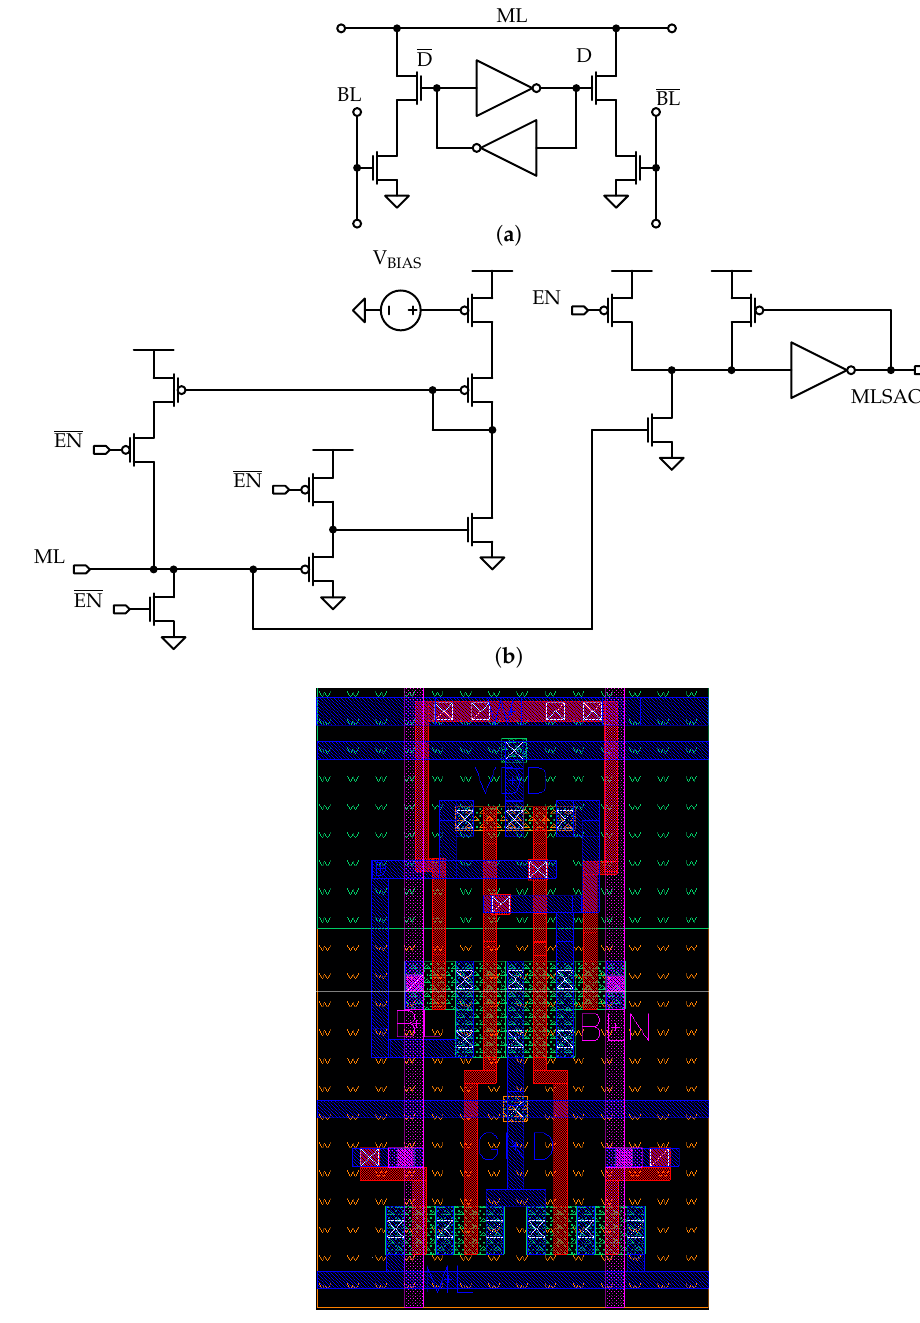
Figure 2. The CAM cell and MLSA. ( a ) Simplified schematic of the 10T NOR CAM cell [32]. The access transistors of the SRAM core are omitted. ( b ) The matchline sense amplifier (MLSA) [34], that employs the current-save sensing scheme for the search operation of the CAM array. ( c ) The CAM cell